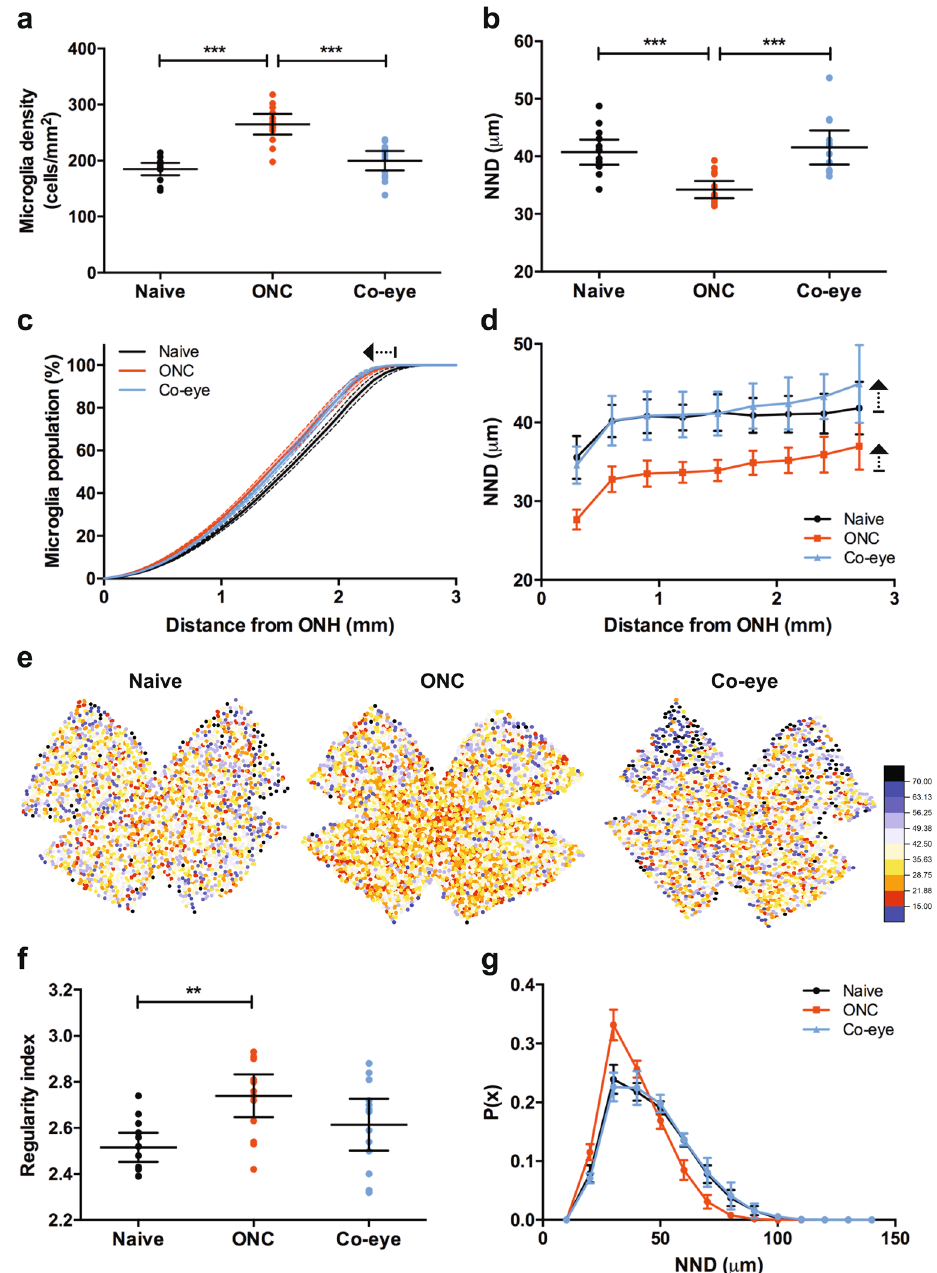
Figure 2. Microglia numbers and distribution. ( a ) A significant increase in overall microglia density is seen when comparing naive versus ONC retinas (4 days post injury). The microglia density of microglia is not significantly different between naive retinas and retinas from the contralateral eye of the ONC animals (one- way ANOVA with Tukey’s post hoc test). ( b ) Nearest neighbour distance (NDD) is significantly higher in ONC retinas, but not in the contralateral eye (one-way ANOVA with Tukey’s post hoc test). ( c ) Plotting cumulative microglia density, depicted as a percentage of the total microglia number, reveals that retinal microglia density is higher in the central regions of retina in ONC and contralateral eyes versus naive eyes. This can be observed as a left-shift of the ONC and Co-eye curves (arrow). ( d ) Distribution analysis of NND, in relation to the distance from the ONH, indicates that overall NND decreases in ONC eyes in comparison to naive eyes. However, NND disproportionally increases in the peripheral retina, a pattern that can also be discerned in the retinas of contralateral eyes (arrows). ( e ) Pseudocolor images of microglia NND/density in retinal whole-mounts. Red-to- blue pseudocolour representation of microglia distribution, ranging from small NND (15 μ m, red tones) to large NND (70 μ m, blue tones). ( f ) The regularity index of the microglia population increases upon ONC (one-way ANOVA with Tukey’s post hoc test). ( g ) A probability function of the NND points out that both the mean NND and NND standard deviation decrease after ONC, which explains the increase in regularity index. Data are depicted as mean ± 95% confidence